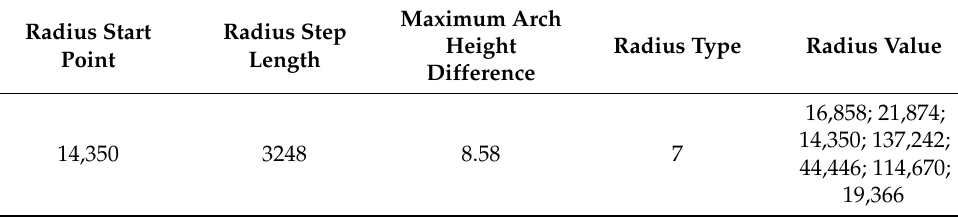
Table 7. Optimization results of the four-span and one-break main curved